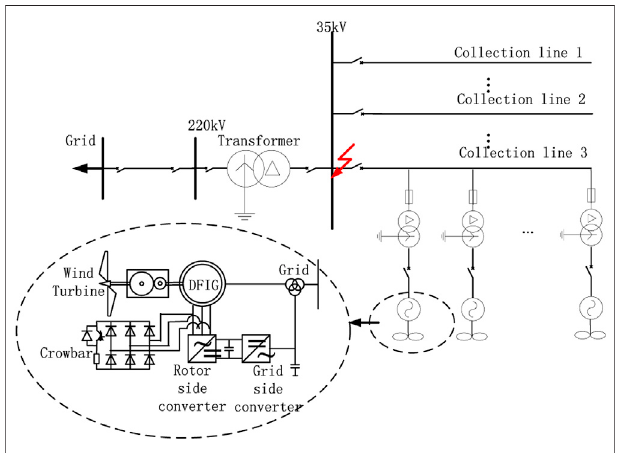
FIGURE 1 | Circuit structure of DFIG wind